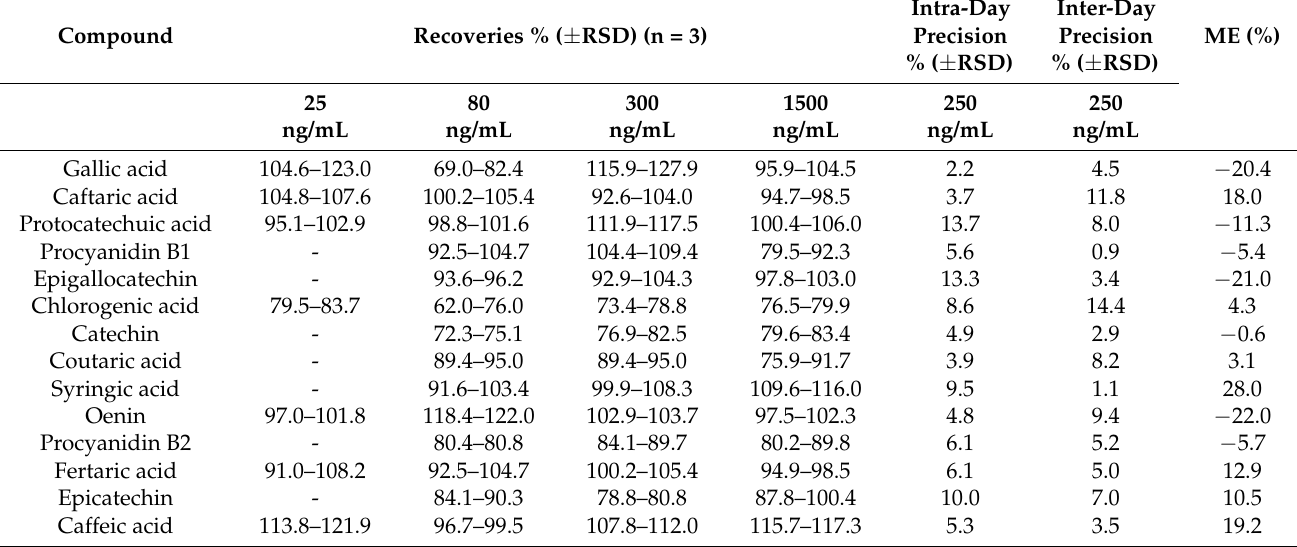
Table 3. Calculation of recovery, precision and ME (matrix effect) for each phenolic